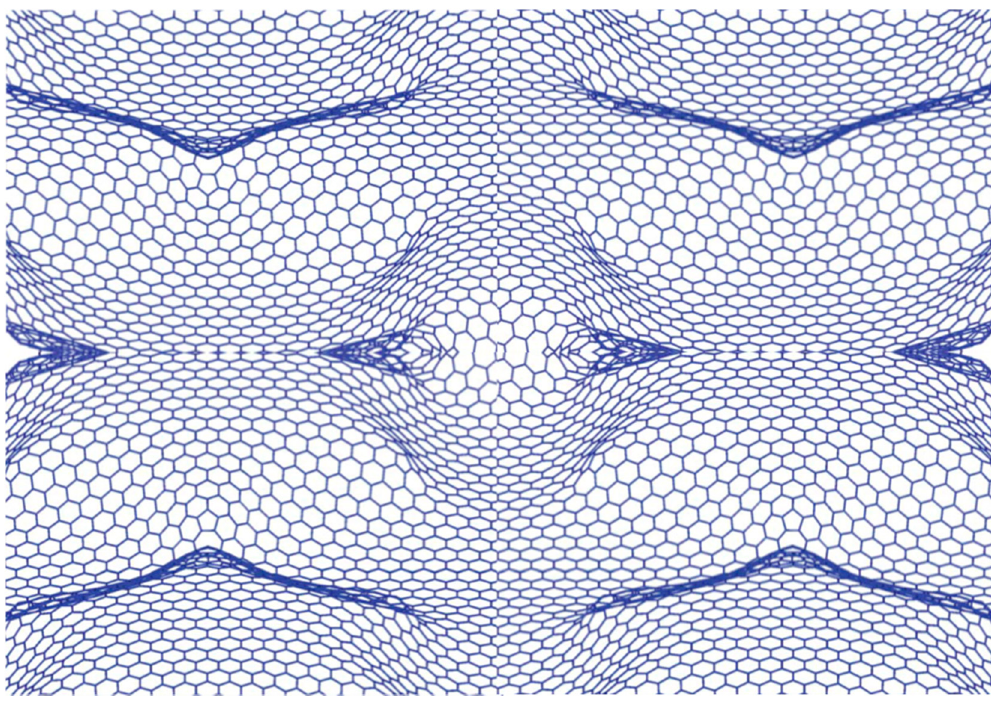
Figure 13. Illustration of graphene buckling landscape obtained through deformation strain and/or perforation. The image reproduced from [ Phys. Today 2020 , 73, 46–52], with the permission of the American Institute of Physics. doi.org/10.1063/PT.3.4569.